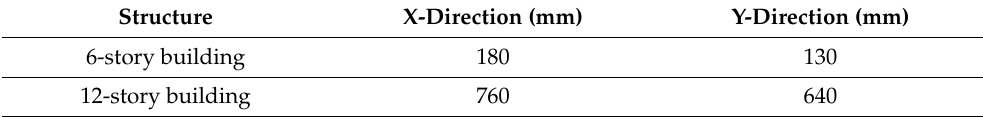
Table 5. Maximum displacement comparison from the response spectrum analysis.